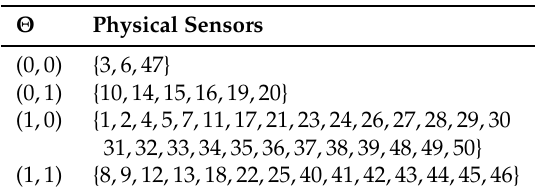
Table 2. Classification results.